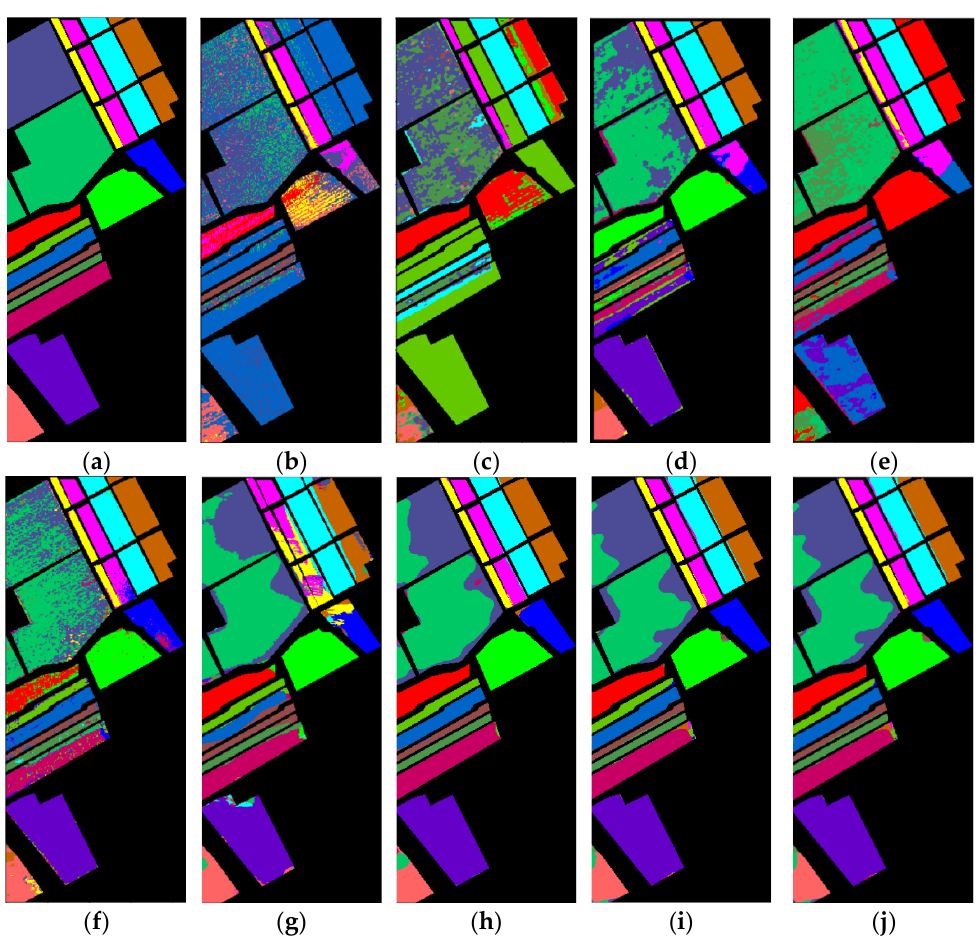
Figure 9. Classification maps resulting from nine different methods for the SA data set with three labeled samples per class. ( a ) Ground-truth. ( b ) Semi-1D CNN (26.94%). ( c ) 3D FCN (28.18%). ( d ) Semi-3D CNN (72.80%). ( e ) 3D CNN (42.56%). ( f ) 1D RNN (80.14%). ( g ) HybridSN (82.34%). ( h ) 3DCSN (91.30%). ( i ) MDSN (91.93%). ( j ) 3D-FHOG + MDSN (93.25%).